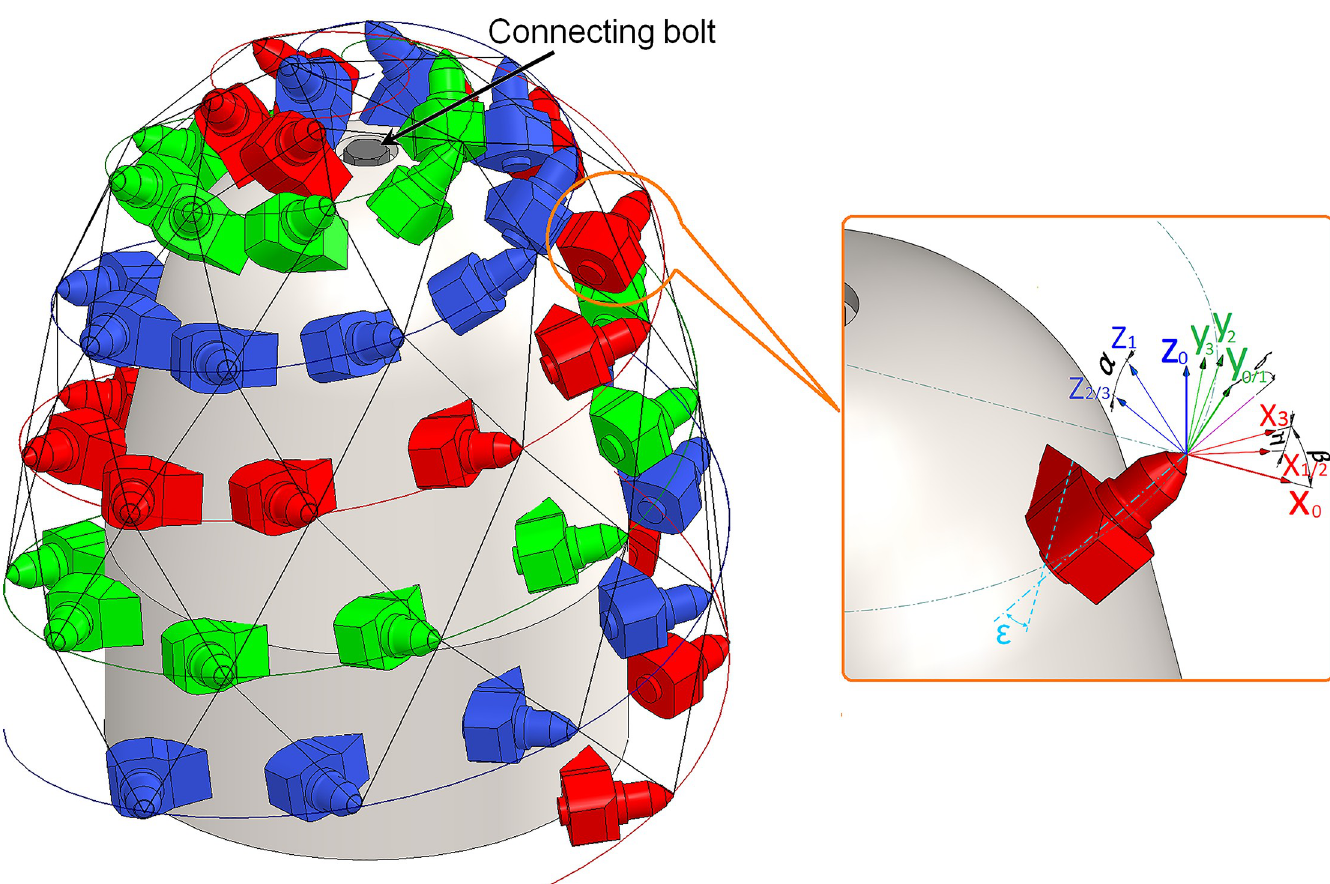
Fig 14. 3D model of CH51 cutting